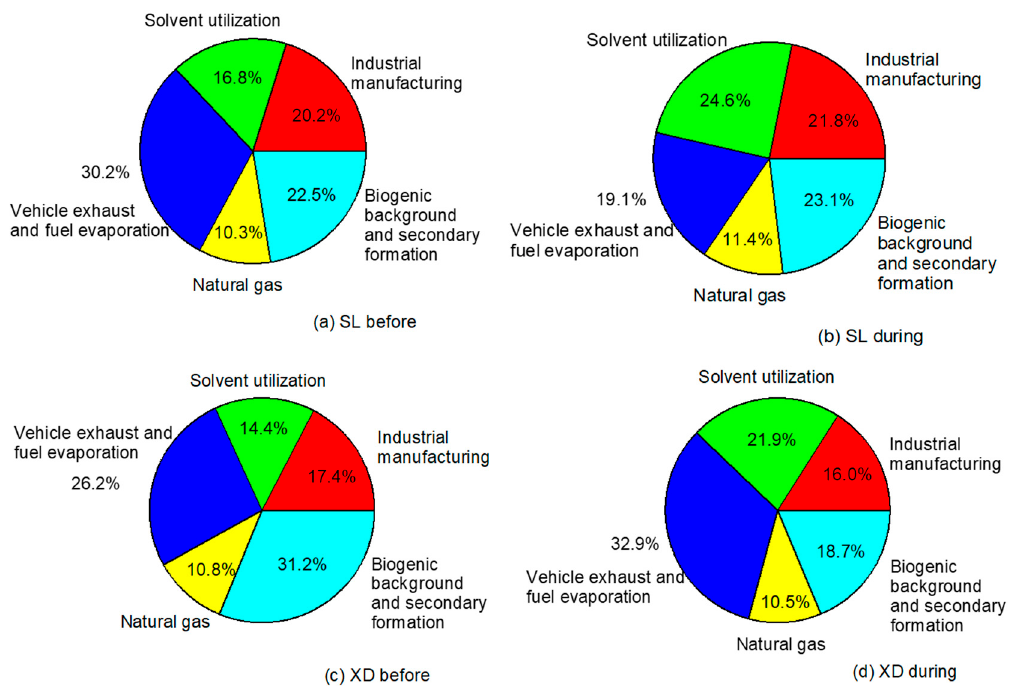
Figure 9. Relative contributions of different sources to TVOC mixing ratios from August 1 – 7 ( a , c , before control) and August 8 – 31 ( b , d , during control) at the SL and XD monitoring sites.